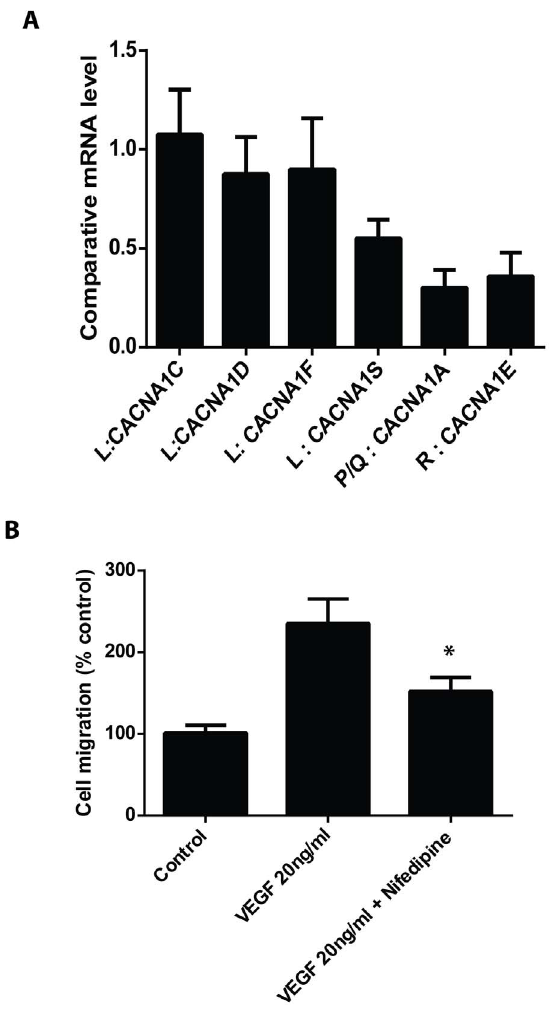
Figure 6. Expression of VDCCs in human brain vascular smooth muscle cells. A, Expression of different types of VDCCs were detected by real-time RT-PCR. B, Wound healing assay was performed with or without nifedipine. *p , 0.05 versus VEGF treated